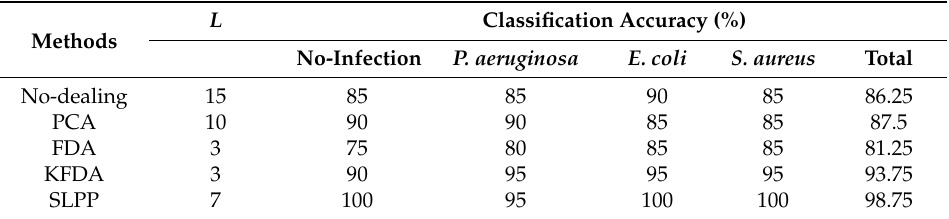
Table 4. Classification results of 10-fold using different data processing methods